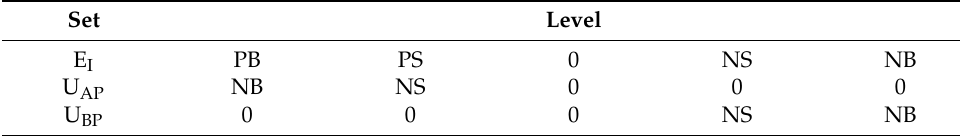
Table 1. Fuzzy rules for dI α p and dI β p .